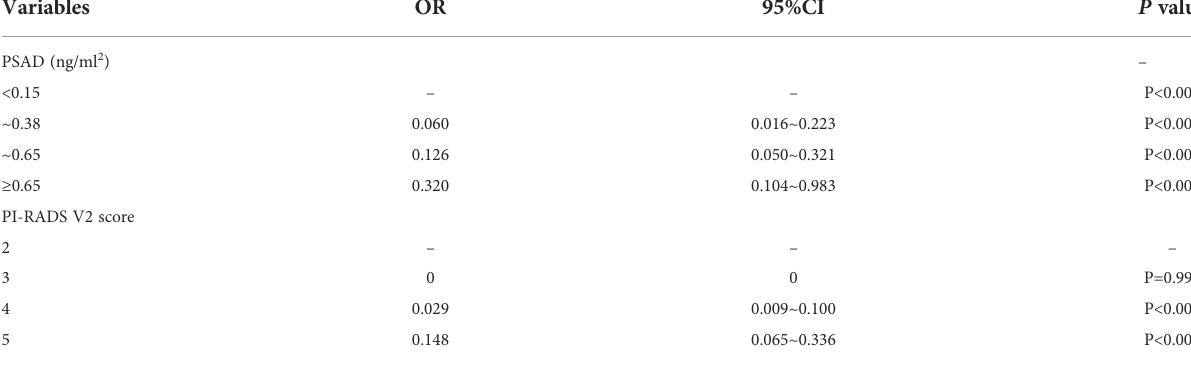
TABLE 4 The multivariate logistic regression analysis of PI ‐ RADS v2 score and PSAD for CSPCa. Variables OR